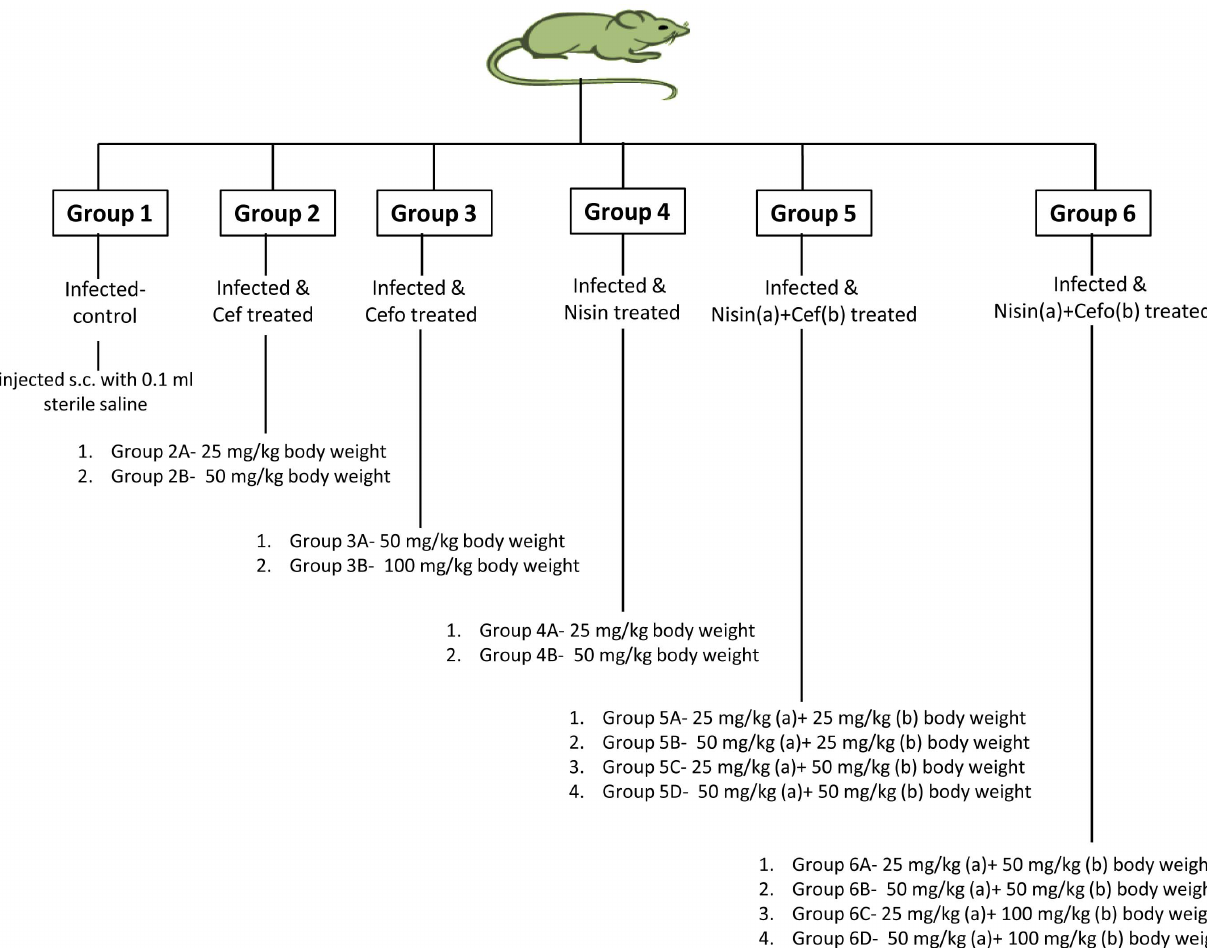
Table 1. MIC values and FIC index of various antimicrobial agents alone and in combinations against Salmonella enterica serovar Typhimurium as determined by broth dilution technique and checkerboard method.